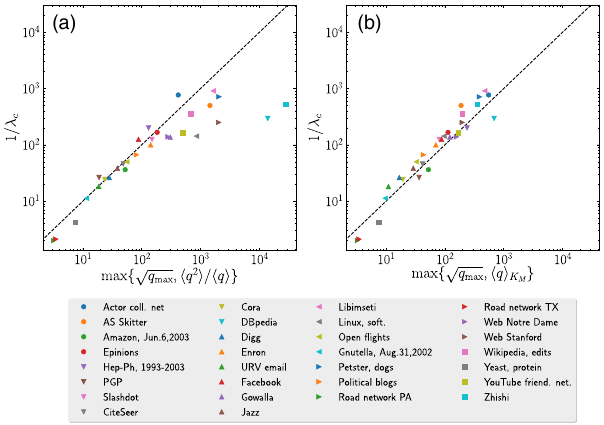
FIG. 6. (a) Numerical estimate of the inverse epidemic threshold 1 = λ , in a subset of the real-world networks considered, as a c function of the inverse largest eigenvalue approximation ffiffiffiffiffiffiffiffiffi p q ; h q 2 i = h q ig . (b) Numerical estimate of the inverse max f max epidemic threshold 1 = λ in real-world networks as a function c of the inverse improved largest eigenvalue approximation ffiffiffiffiffiffiffiffiffi p q ; h q i max f g . Data for the networks Zhishi , Web Notre max K M Dame , Road network TX , and Road network PA are lower bounds to the real threshold due to computing-time